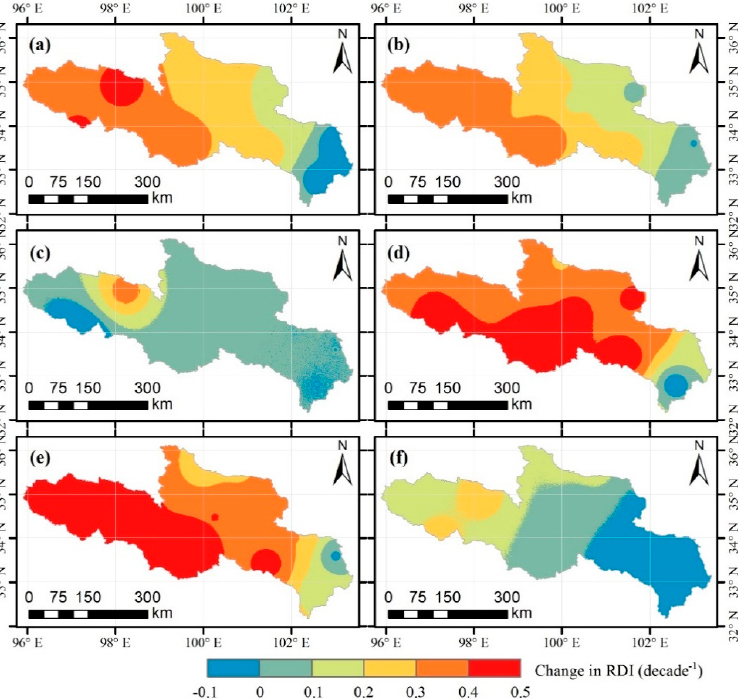
Figure 4. Changes in RDI over SRYRB during the period 1960–2015 on the ( a ) annual, ( b ) vegetation growing seasonal (VGS) and ( c – f ) seasonal scale: ( c ) autumn, ( d ) winter, ( e ) spring and ( f ) summer. As shown in Figure 5, the interannual variations of RDI at different time scales were calculated over SRYRB during the study period. According to the variation of annual RDI shown in Figure 5a, the trend of annual RDI increased significantly from 1960/1961 to 2015/2016. Two stages can be found in the course of annual RDI variations. (1) The first stage, named the drought stage, was from 1960/1961 to 1979/1980. In this stage, the values of RDI were negative except during the years 1963/1964, 1966/1967, 1971/1972, 1974/1975 and 1975/1976. (2) The second stage, named the wetness stage, was from 1980/1981 to 2014/2015. During this stage, the majority of RDI values were positive, showing a clear trend of increasing wetness in comparison to the previous period. According to the cu- mulative curve of annual RDI, the change from drought to wetness was evident, with the turning point being in the early 1980s. As for VGS RDI (Figure 5b), its variation is very similar to that of annual RDI. On annual and VGS scales, the average change rates of RDI over SRYRB were 0.26 decade − 1 and 0.24 decade − 1 , respectively.